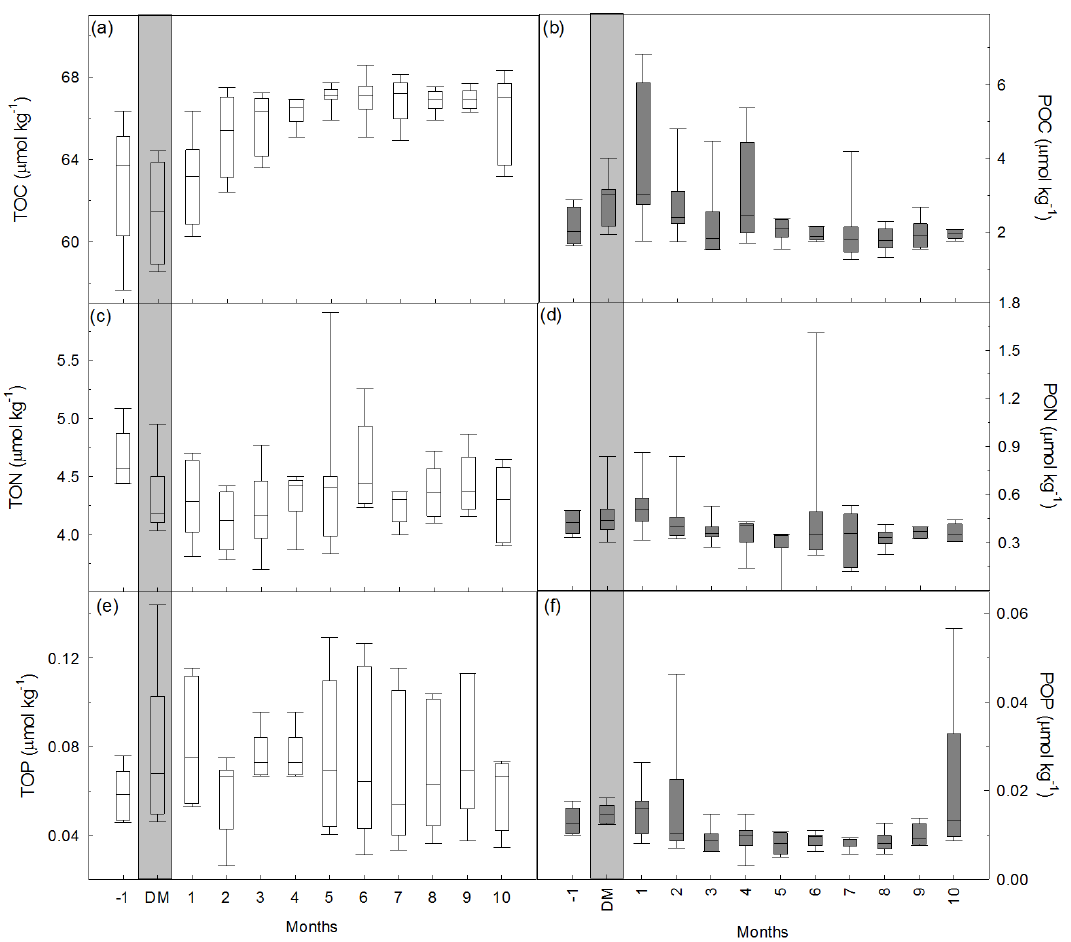
Figure 4. Box–whisker plot comparing the annual concentrations of total (open bars) and particulate organic matter (filled bars) relative to the deep mixing at a depth of 0–25m at BATS (data used are from January 2005 to December 2011). Bottom and top of the box define the 25 and 75% data distribution, and the error bars define the 5 and 95% data distribution. The dark gray vertical bar represents the period of deep mixing (DM) for each